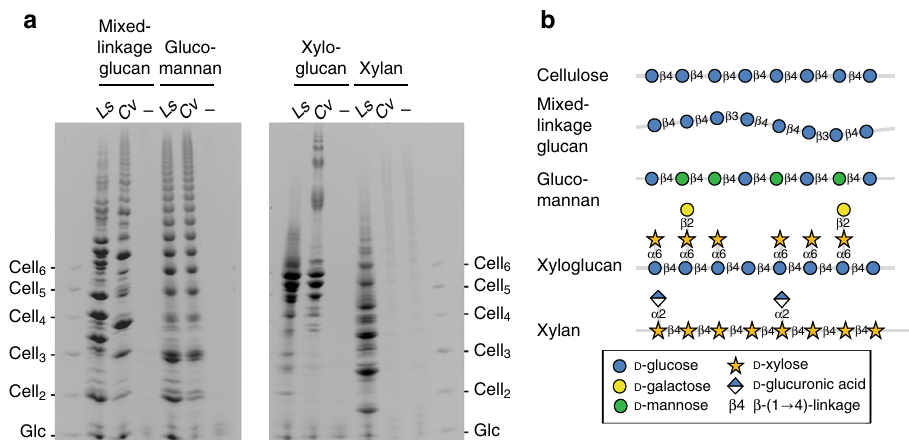
Fig. 2 Comparison of Ls AA9A and Cv AA9A action on non-cellulosic substrates. a PACE gel showing digestion products on lignocellulosic polysaccharides with 4 mM ascorbate reducing agent. Ls , Ls AA9A; Cv , Cv AA9A; − , no enzyme (performed in triplicate). The migration standards are